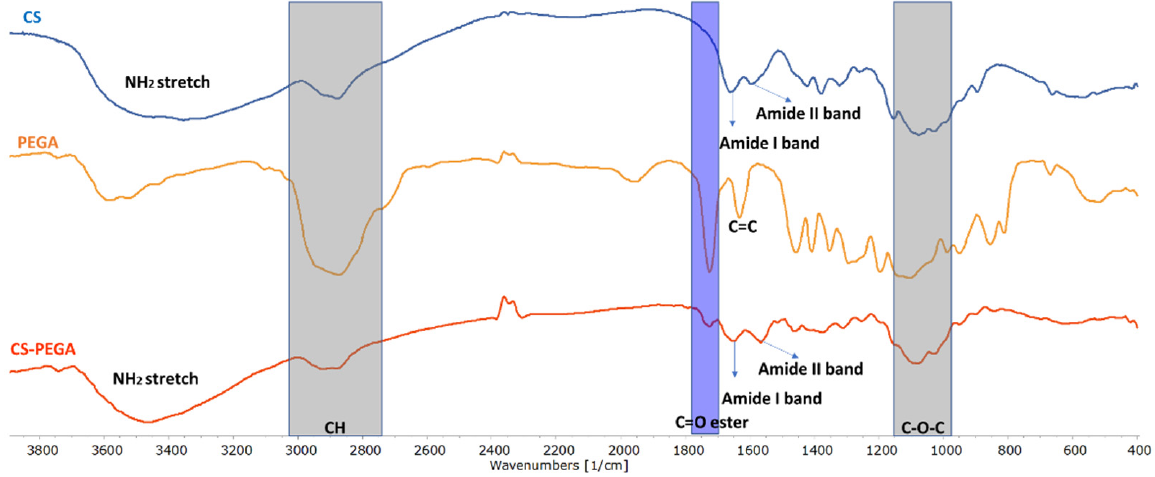
Figure 1. CS, PEGA, and CS-PEGA-FTIR spectra.